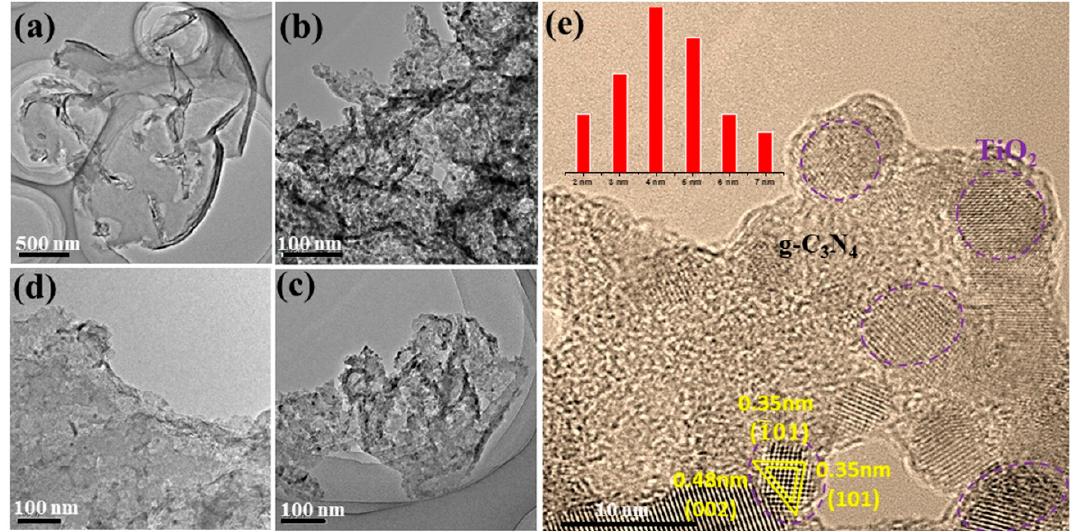
Figure 3. TEM images of ( a ) g-C 3 N 4 nanosheets, ( b ) PTC-20, ( c ) PTC-40 and ( d ) PTC-60, ( e ) is the enlarged image of PTC-40, inset: size distribution of TiO 2 QDs in